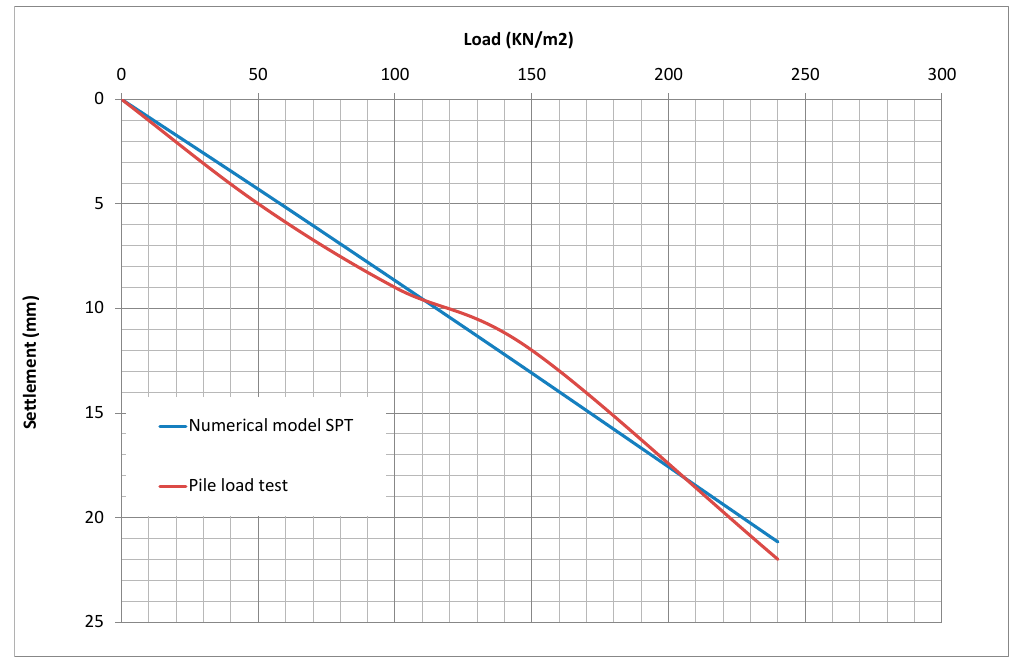
Figure 13. Model analytical outputs for the SPT average compared to a large-scale load test.